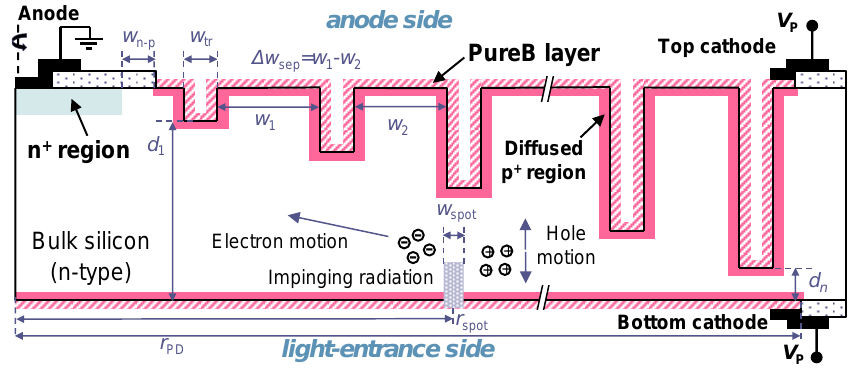
Figure 2. Cross section of the basic TDD (trenched drift detector) structure.